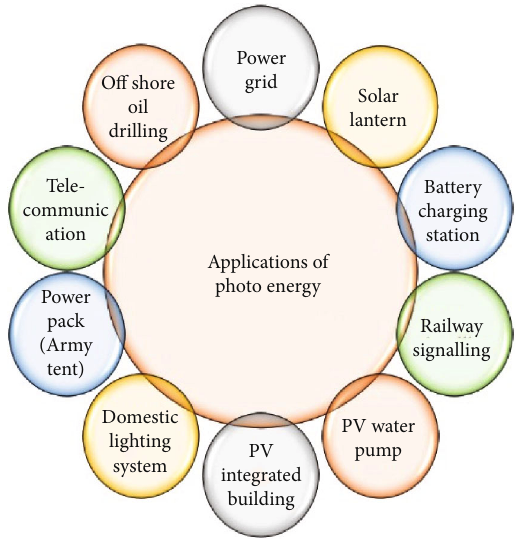
Figure 1: Shows applications of photo